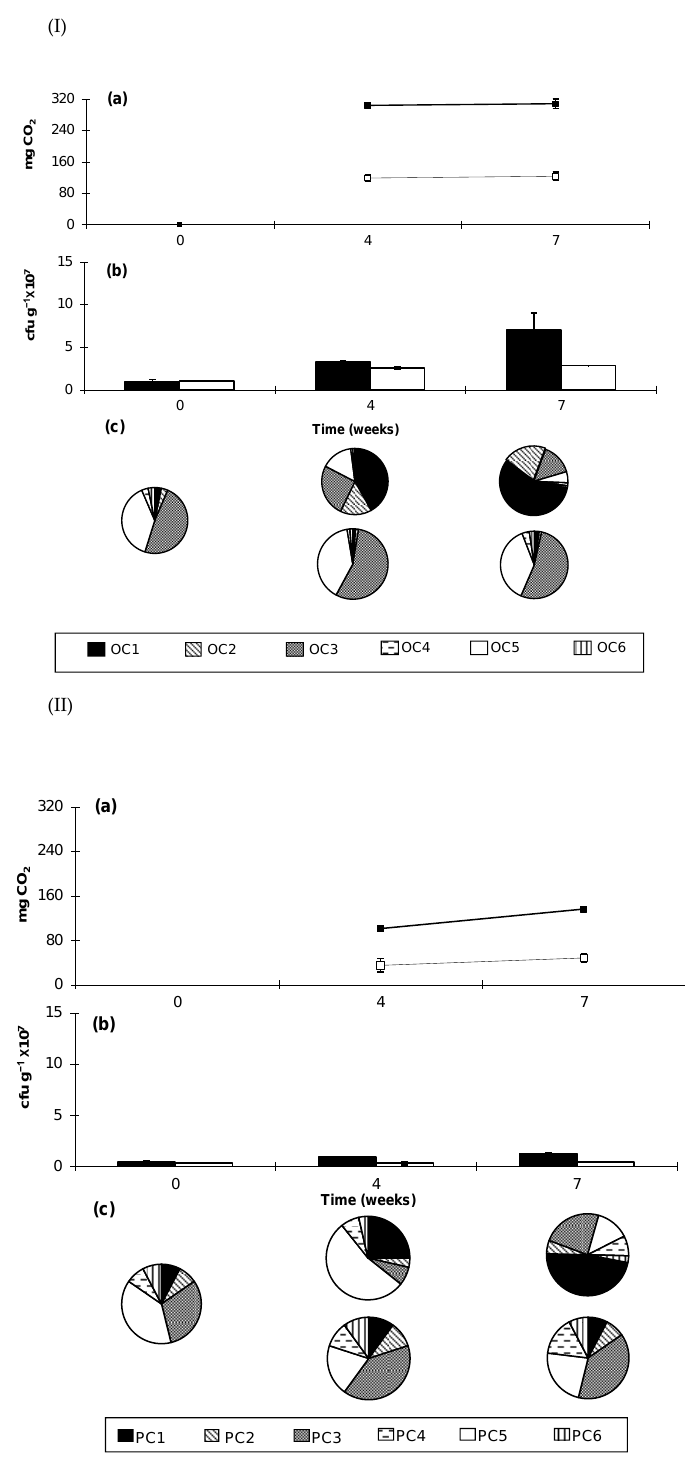
Figure 2. Results regarding ( a ) soil respiration (average ± se), ( b ) abundance of the community of culturable bacteria (average ± se) and ( c ) relative participation of the isolated main bacterial strains in enriched with 1,8-cineol (C) and in control soil samples, from ( I ) an oak forest (O) and ( II ) phrygana (P). 1,8-Cineol was added every week. Measurements for ( b , c ) were taken at the start of the experiment and then on the 4th and 7th week; measurements for ( a ) started on the 4th week. In ( a , b ), white colour corresponds to control soil samples and grey to enriched ones. In ( c ), the upper row corresponds to treated samples and the lower to control samples. For the bacterial codes, see note 1 under Table